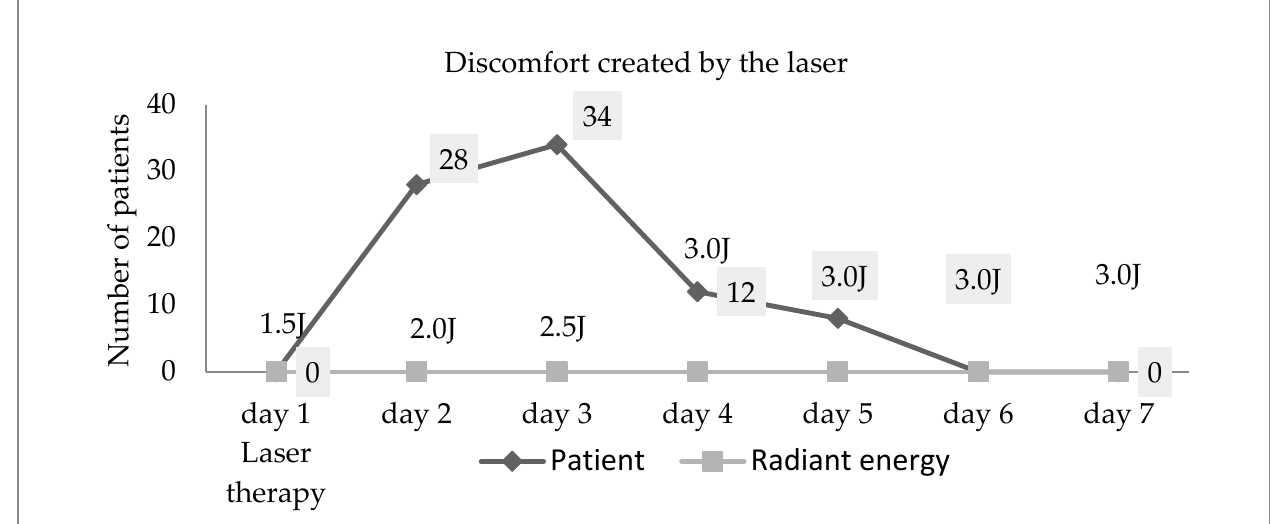
Figure 4. Discomfort created by the laser therapy treatment. The high-intensity laser treatment of the perianal fistulas, in all 50 cases, was proven to be efficient with a positive and promising impact both on the local signs and symptoms and also on the persistence of the external orifice of the fistula. This was evident given the fact that 44 out of 50 patients’ check-ups were made every three weeks, and after twelve weeks, they did not need the fifth check-up anymore due to the fact that they had favorable evolution post-treatment, or they went to another medical center for diagnosis and treatment. As we mentioned earlier, two of the women needed readmission into the hospital, and the laser treatment was repeated. Regarding the control group, 37 of them needed a second admission to the hospital after six months of check-ups due to the recurrence of the fistula, to which we applied the same laser treatment mentioned in the previously presented study. Thirteen patients did not show up at their regular check-ups, probably because of the absence of the recurrence of the symptoms, or maybe they presented to another medical